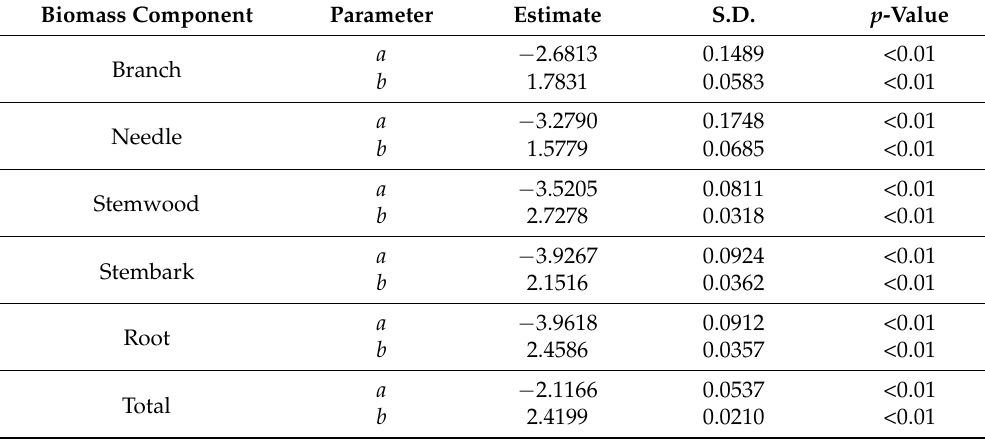
Table 3. Parameter estimates of the general biomass model (Equation